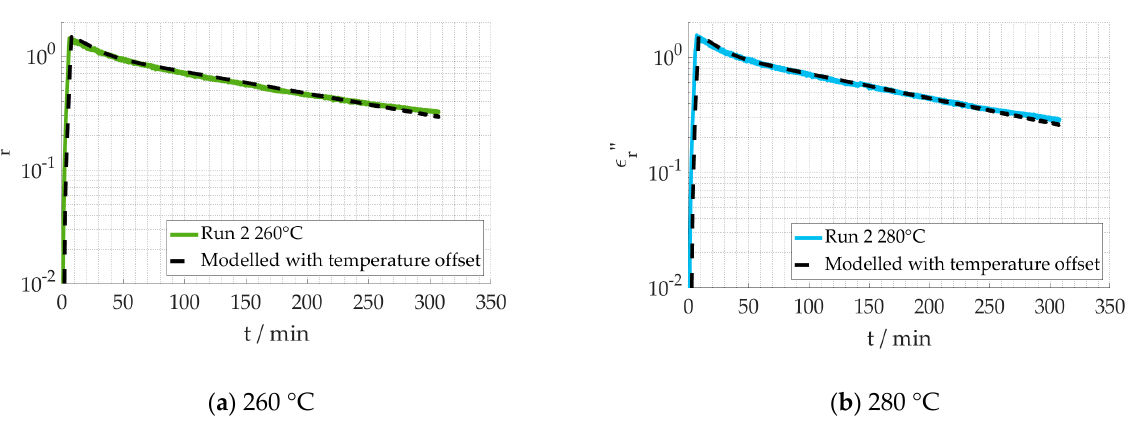
Figure 11. Logarithmical comparison between measured dielectric loss and fitted values using a temperature offset.